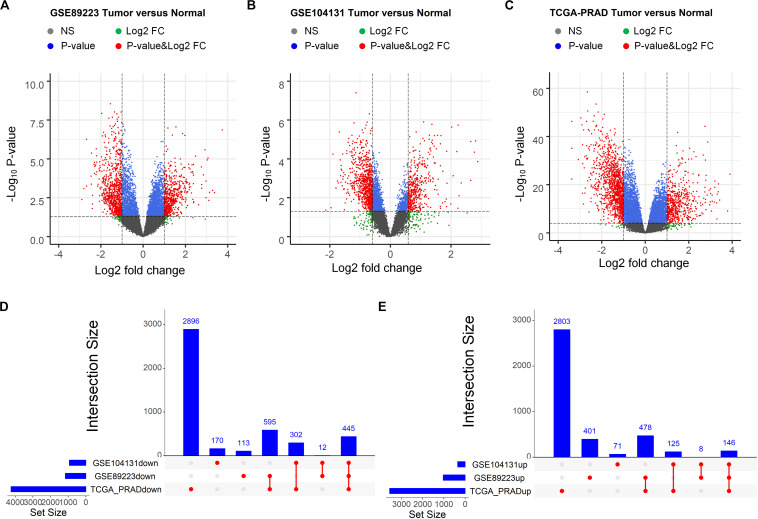
Identification of differentially expressed mRNAs between prostate tumor tissue and normal control. (A–C) Volcano plot of differentially expressed mRNAs derived from three independent PCa related studies: GSE89223 (A), GSE104131 (B) and TCGA-PRAD (C). Red spots represent significantly deregulated mRNAs. (D,E) UpSet plot of overlapping up regulated and down regulated mRNAs from three independent PCa related studies.